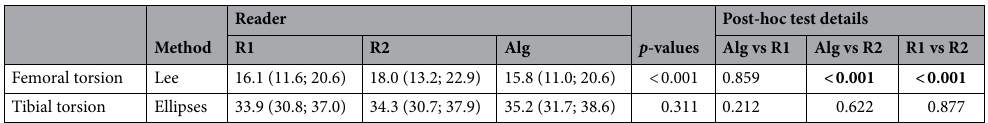
Table 1. Mean femoral and tibial torsion as determined by the Lee and ellipses methods. Readers are radiologist 1 (R1), radiologist 2 (R2), and the algorithm (Alg). Means (95% confidence intervals) [°]. Statistical analysis was performed by repeated measures ANOVA followed by pair-wise Tukey’s post-hoc test. Results of the other methods of determining femoral (according to the Reikeras, Tomczak, and Murphy methods) and tibial torsion (according to the bimalleolar and talus methods) are detailed in Supplementary Table 2. Adjusted p -values with significant differences indicated in bold